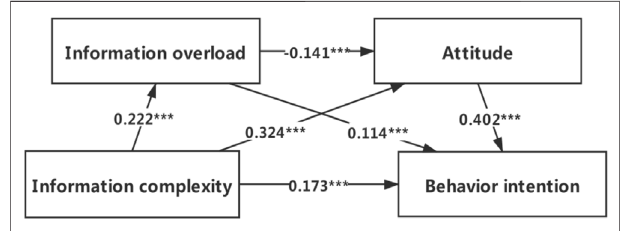
FIGURE 1 | Serial multiple mediating model of information complexity, information overload, attitude and behavior intention. *** p < 0.001.